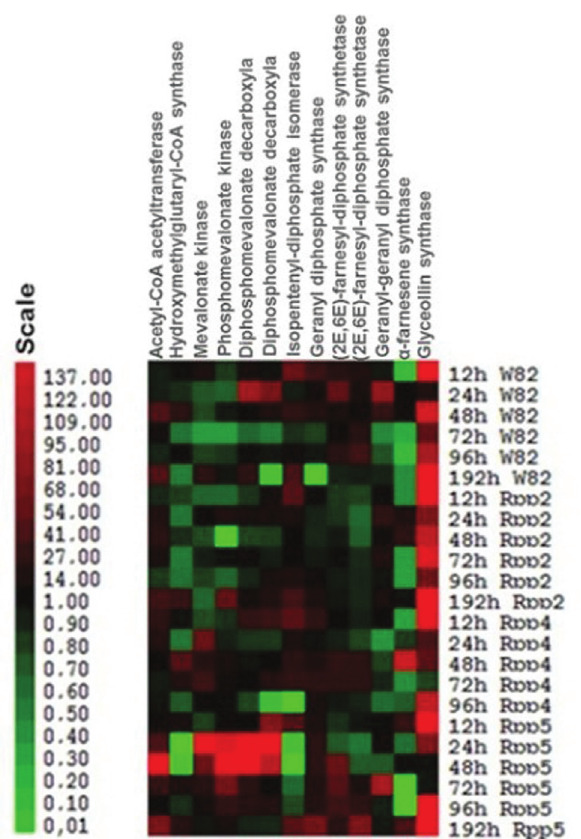
Figure 2 - Expression profiles of the genes involved in terpenoid and glyceollin biosynthesis in soybean after infection with P. pachyrhizi . Ex- pression values are presented as the log2 of the RQ (relative quantifica- tion) values determined by the Software REST (Relative Expression Soft- ware Tool) (Pfaffl et al. , 2002). These values were converted into a colorimetric scale by the Cluster and Tree View software. Legend: W82 refers to the susceptible cultivar Williams 82, Rpp2 to the resistant PI 230970, Rpp4 to PI459025 and Rpp5 to PI200487. Enzymes: 2.3.1.9, acetyl-CoA acetyltransferase; 2.3.3.10, hydroxymethylglutaryl-CoA syn- thase; 2.7.1.36, mevalonate kinase; 2.7.4.2-phosphomevalonate kinase;